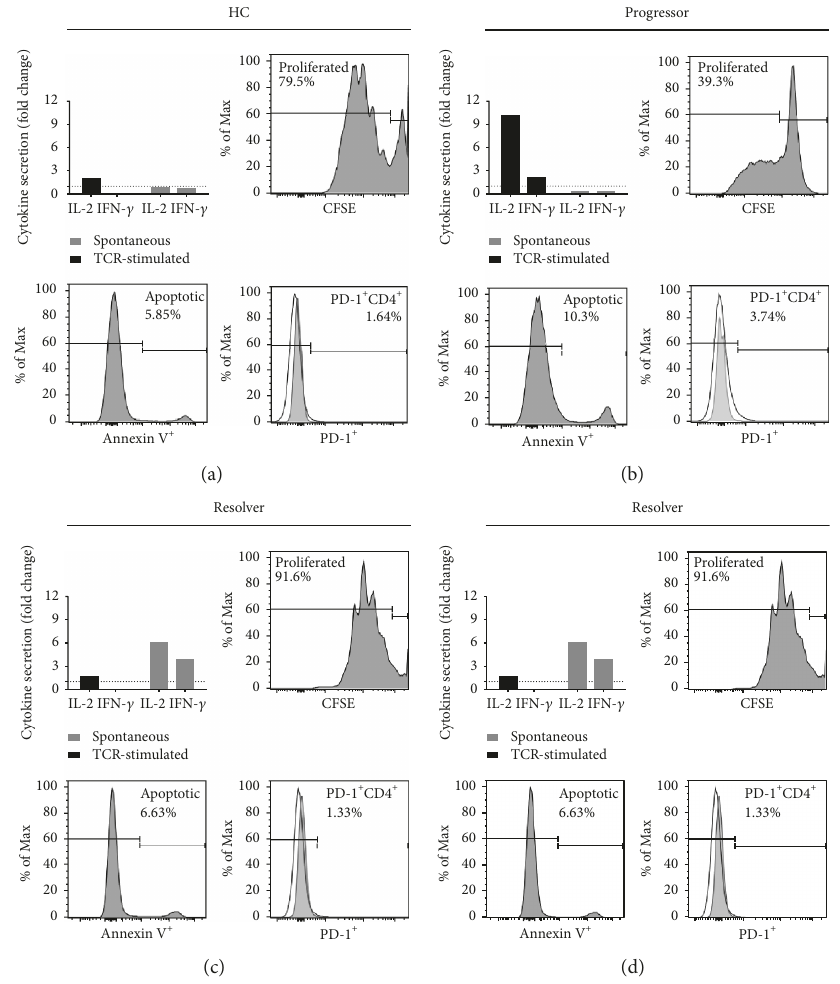
Figure 5: CD4 + T cells from sarcoidosis progressors exhibit characteristics of exhaustion. (a, b, and c) Representative functional data for a single healthy control, sarcoidosis progressor, and sarcoidosis resolver. (a) Cytokine secretion; data have been normalized to the mean value for the healthy control cohort (hashed line). (b and c) Proliferation analysis. (a) Apoptosis analysis. (b and c) Percent PD-1 + CD4 + T cells; overlay of naïve (CCR7 + CD45RO − ; shaded) CD4 + cells and total CD4 + T cells (unshaded). (d) Immune activity of sarcoidosis progressors ( n = 12 ) and resolvers ( n = 5 ) relative to healthy controls. High =activity greater than one standard deviation above the healthy control mean (yellow). Low=activity greater than one standard deviation below the healthy control mean (magenta). Normal = within one standard deviation of the healthy control mean (grey). White spaces indicate data not present due to lack of available